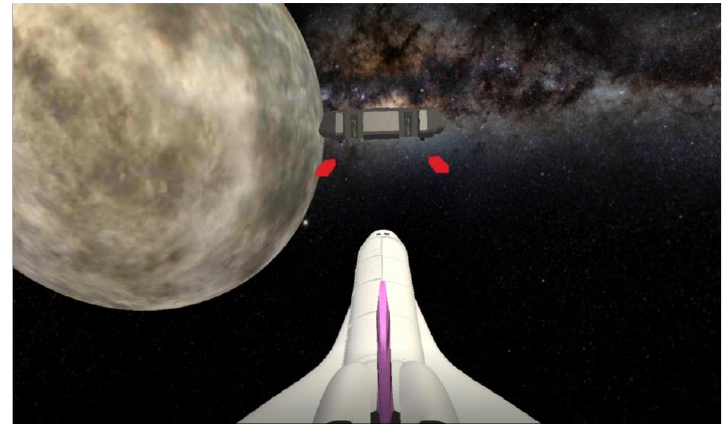
Figure 11. Alien spaceship attacking the human spacecraft.